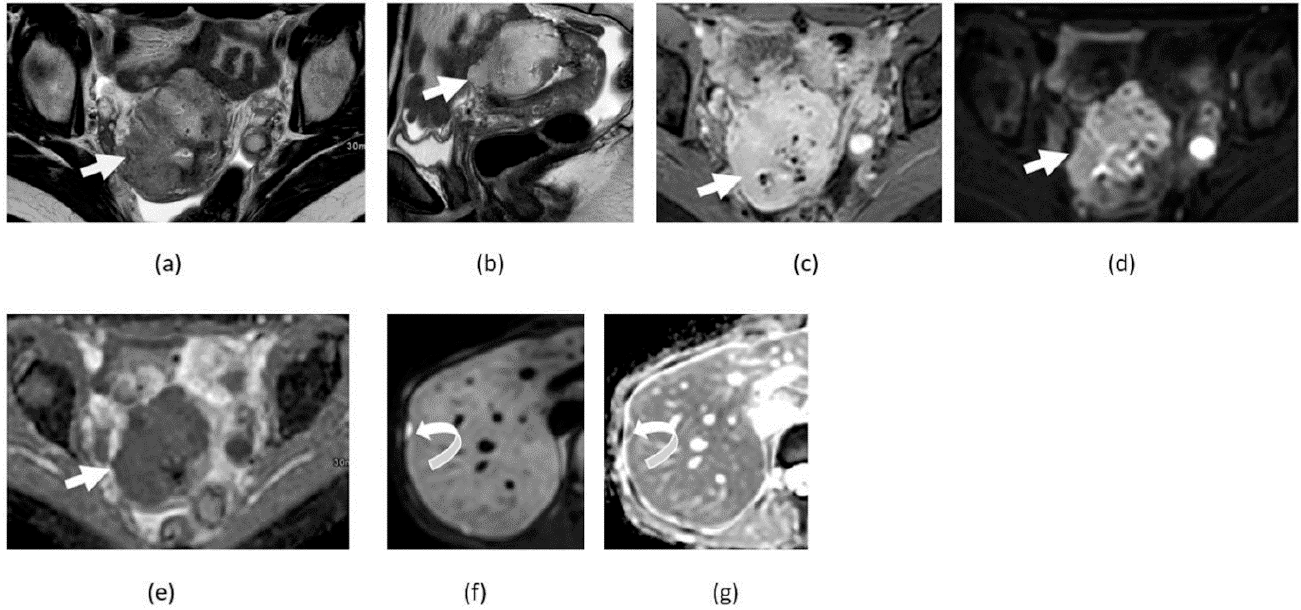
Figure 4. Axial ( a ) and sagittal ( b ) T2-weighted, axial contrast-enhanced T1-weighted ( c ), DWI ( d ), and ADC map ( e ) images of the pelvis showing bulky irregular enhancing anterior uterine wall mass (arrows) with high signal on DWI and marked low signal ADC map consistent with pronounced restricted diffusion from biopsy proven as uterine leiomyosarcoma. Axial DWI ( f ) and ADC map ( g ) of upper abdomen image of the same patient shows a same pattern of restricted diffusion on the capsular liver metastatic lesion (curved